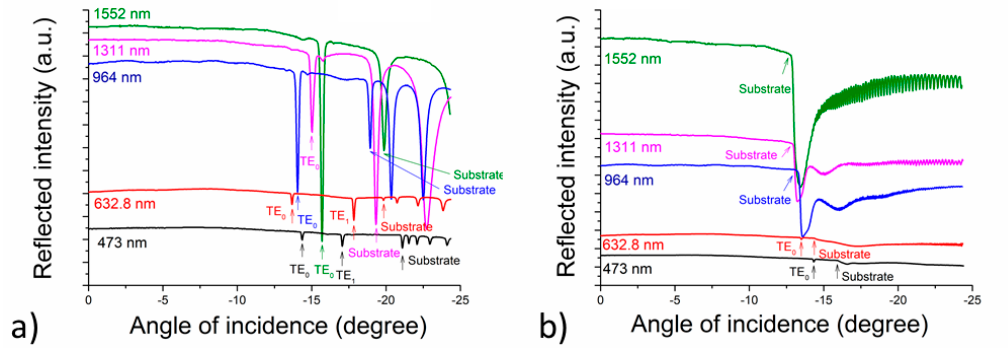
Figure 6. The assessment of the critical angles of incidence θ c used for the evaluation of the refractive indices of the silk deposited onto: ( a ) a silica-on-silicon substrate (silk #1); and ( b ) a borosilicate glass substrate (silk #2).